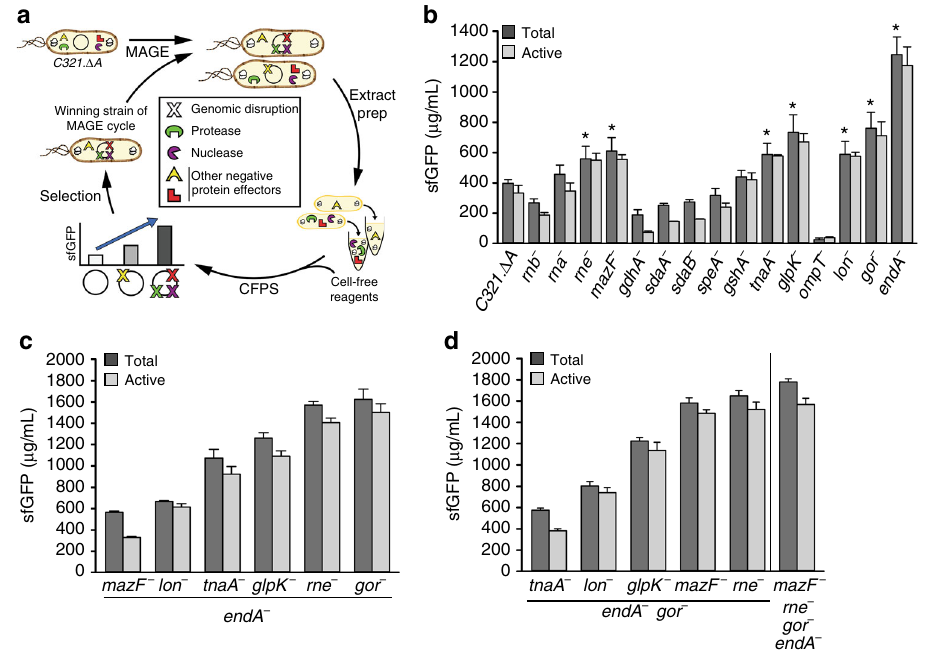
Fig. 2 Engineering C321 . Δ A variants for enhanced CFPS. a Schematic of design-build-test cycles employing multiplex automated genome engineering (MAGE) to disrupt putative negative protein effectors (Supplementary Table 1) in engineered C321 . Δ A strains for producing extracts with enhanced cell- free protein synthesis (CFPS) yields. b Cell extracts derived from C321 . Δ A and genomically engineered strains containing a single putative negative effector inactivation were screened for sfGFP yields. Bene fi cial mutations that increase active yields ≥ 50% relative to C321. Δ A are highlighted with an *( p < 0.01, Student ’ s t -test). c C321 . Δ A . 542 ( endA − ) was chosen as the next base strain and the following bene fi cial disruptions were pursued in combination: rne , mazF , tnaA , glpK , lon , and gor . d C321 . Δ A . 709 ( endA − gor − ) was selected as the subsequent base strain for triple and quadruple mutant construction. C321 . Δ A . 759 ( endA − gor − rne − mazF − ) yielded the highest level of CFPS production. Total sfGFP concentration was measured by counting radioactive 14 C- Leucine incorporation and active protein was measured using fl uorescence. Three independent batch CFPS reactions were performed for each sample at 30 °C for 20 h ( n = 3). Error bar = 1